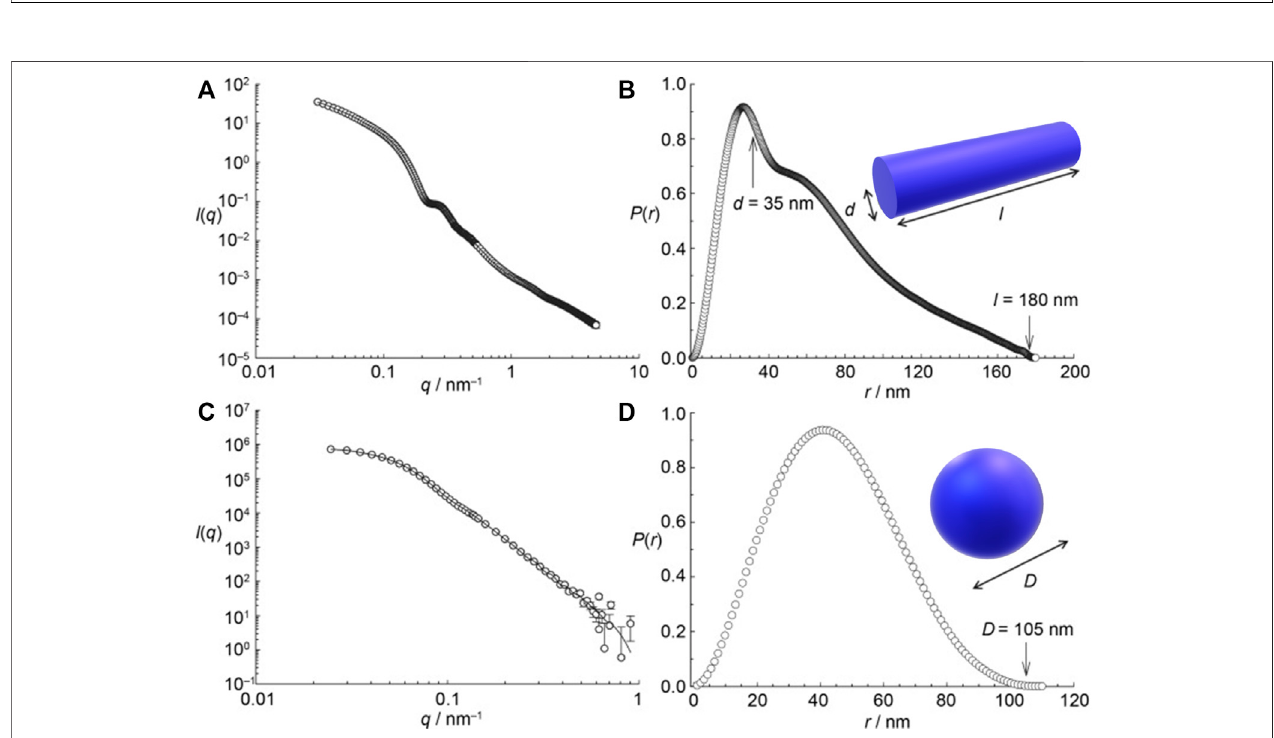
FIGURE 6 | Small-angle scattering characterization of dendrimer-naphthalene dicarboxylic acid dye assemblies: (A,B) with 1,4-naphthalene dicarboxylic acid; (C,D) with 2,3 -naphthalene dicarboxylic acid; both with a loading ratio of 2:1; left: scattering curves I(q), right: pair distance distribution functions P(r). I(q) and P(r) are in arbitrary units. 1,4-NDC yields cylindrical aggregates but 2,3-NDC spherical aggregates (Gröhn et al., 2008). Reprinted with permission. Copyright © 2008 WILEY-VCH Verlag GmbH and Co. KGaA, Weinheim.